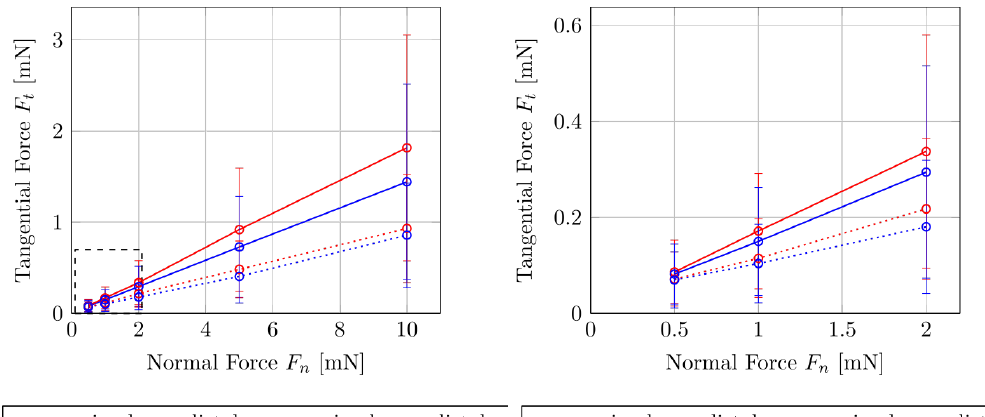
Figure 2. Tangential and normal forces measured in the tibia–tarsus joint of P. marginata by nanotribometer NTR 2 . Error bars show standard deviations of the means. The dashed box indicates the detailed plotted data on the right. Distal: in the distal sliding direction. Proximal: in the proximal sliding direction. Index f: fresh sample condition. Index d: dry sample condition.